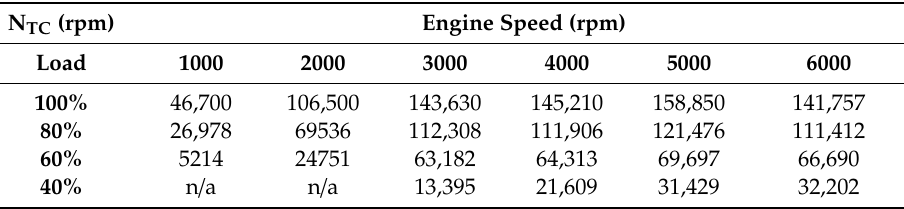
Table 5. Turbocharger speed